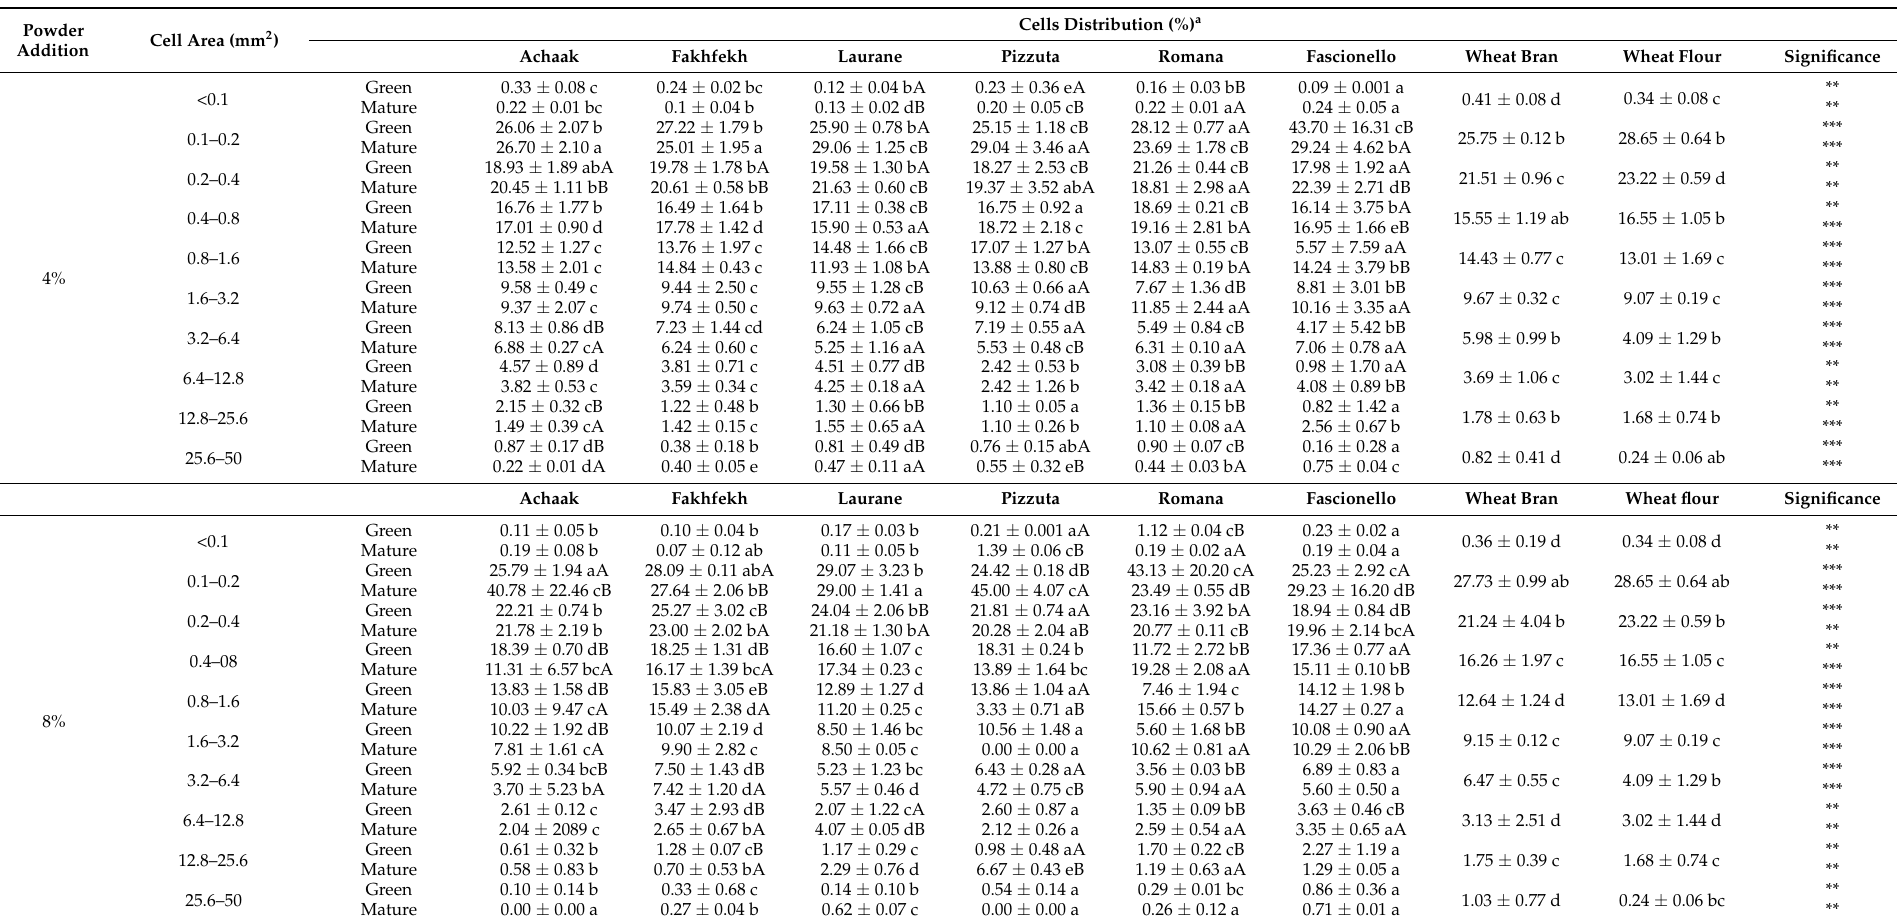
Table 8. Values of cell distribution for each cell area in the breads substituted with AH powders and results of variance analysis with Duncan’s test ( p < 0.05) performed between the products and the two harvesting times (green and